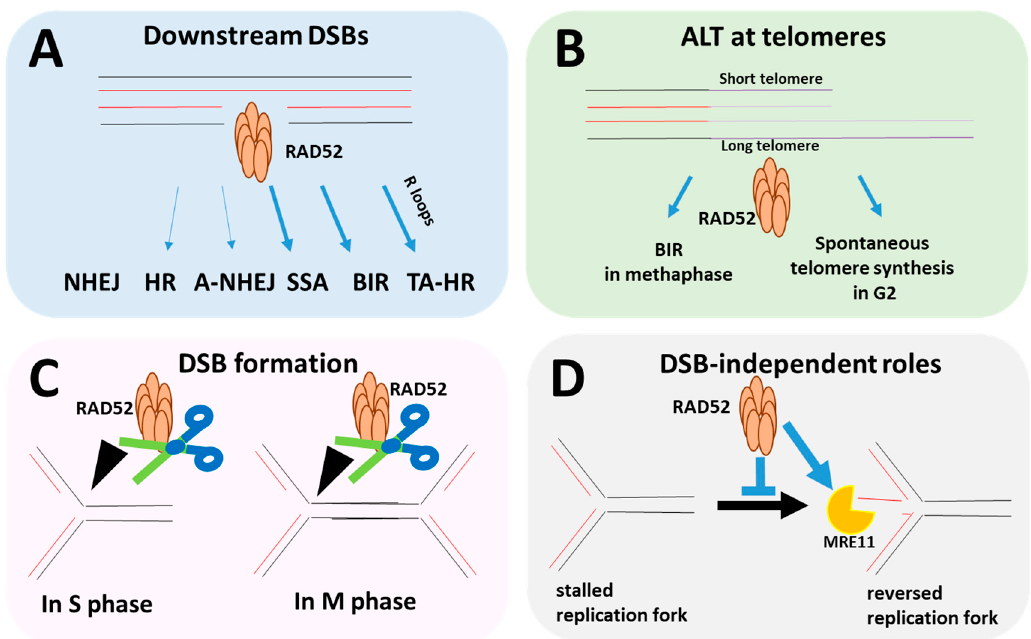
Figure 1. Multiple roles of RAD52 during DNA replication and repair. ( A ) RAD52 participates in various DNA double-strand break (DSB) repair processes by means of its strand-annealing activities. In some pathways, RAD52 acts as a backup factor (e.g., HR), while in others, it is absolutely required, e.g. single-strand annealing (SSA) at DSBs and break-induced replication (BIR) at single-ended DSBs (which are not shown in this scheme) [8,9,13], ( B ) RAD52 participates in the alternative lengthening of telomeres. RAD52 plays a role in BIR-mediated elongation of telomeres during pro-metaphase, but also promotes spontaneous telomere elongation in G2, independently of the SLX4 nuclease [11,14,15]. ( C ) RAD52 has also been implicated in the facilitation of DSB formation by MUS81 in Chk1-depleted cells and during MiDAS [10,16,17]. ( D ) DSB-independent roles of RAD52 were also reported in S phase. RAD52 prevents unleashed fork reversal, but once forks have reversed, it can facilitate MRE11-dependent degradation of newly synthesized DNA [12,18,19]. Template DNA: black, copied strand: red and violet strands: telomeric regions.